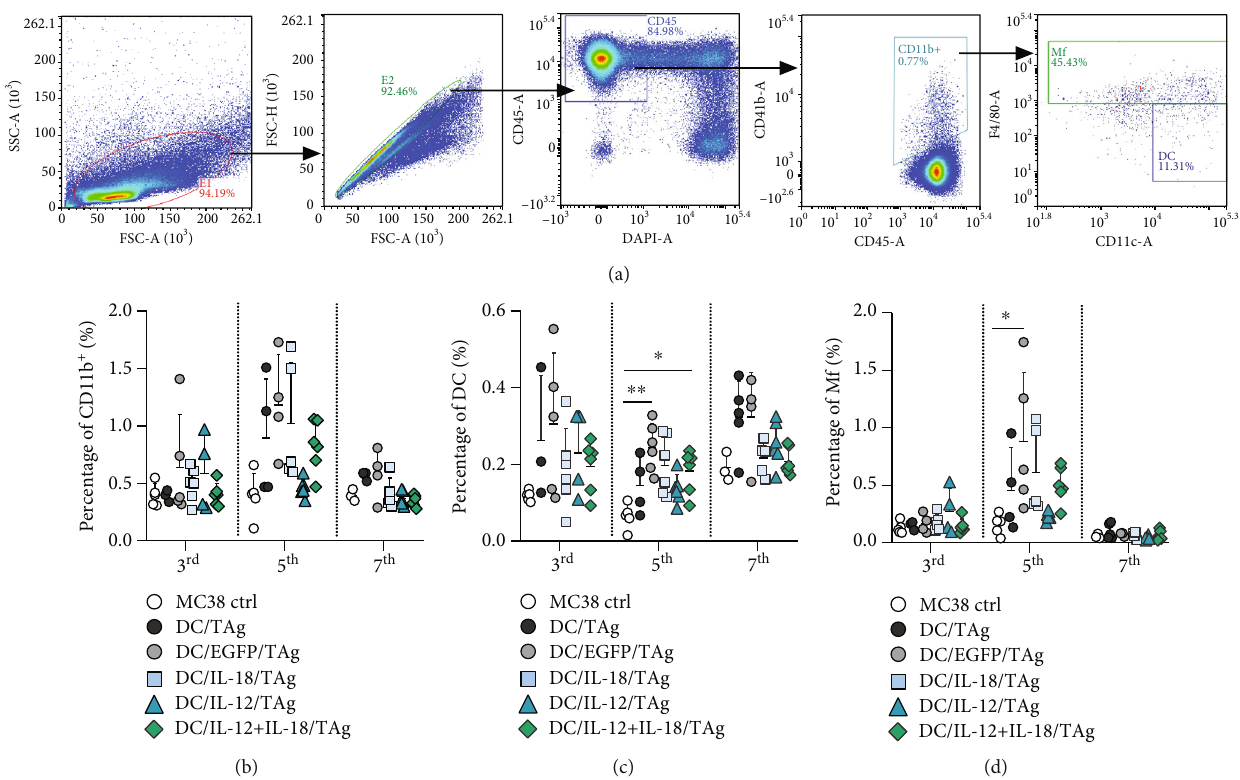
Figure 7: Evaluation of myeloid cell subpopulation in tumor-draining lymph nodes after administration of vaccine cells. (a) Scheme of the multiparameter fl ow cytometric analysis of DC and Mf on the 3rd, 5th, and 7th days after single injection of DCs in tumor-draining lymph nodes. The analysis was started by eliminating debris and cell aggregates; then, live leukocytes (DAPI - CD45 + ) were gated, and among them, CD11b + myeloid cells were identi fi ed. The CD11b + cells were subsequently separated for expression of the CD11c + marker. Among the CD11c + cells, the DC (CD11c + F4/80int) and TAM (CD11c + F4/80 + ) populations were identi fi ed. (b) Percentage of CD11b + cells in lymph nodes. (c) Percentage of DCs in lymph nodes. (d) Percentage of Mf in lymph nodes. Results are presented as mean + SD calculated for 5-6 mice per group. Di ff erences between groups were estimated using the parametric Brown-Forsythe and Welch ANOVA test followed by Dunnett ’ s T3 multiple comparison post hoc test ((c) percentage of DC cells on the 5th day) or the nonparametric Kruskal-Wallis test followed by Dunn ’ s multiple comparison post hoc test ((d) percentage of Mf on the 5th day) ( ∗ p < 0 : 05 , ∗∗ p < 0 : 01